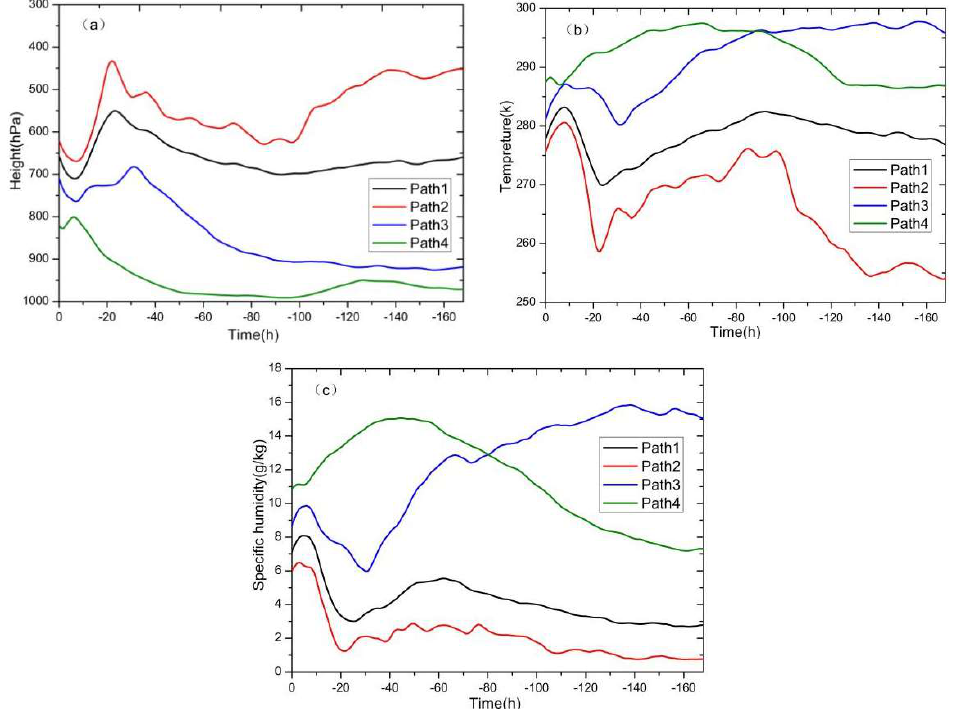
Figure 12. Changes in moisture paths with respect to height ( a ), temperature ( b ) and specific humidity ( c ).